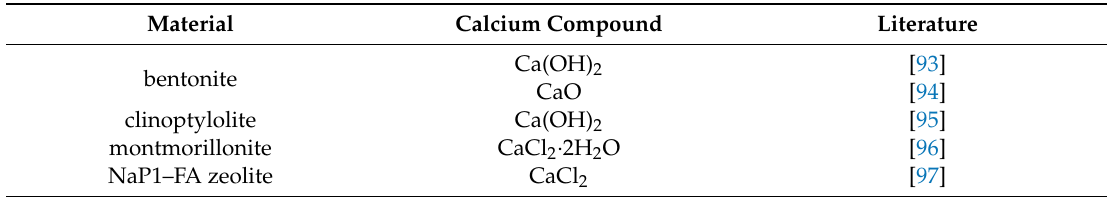
Table 3. Calcium compounds modification of reactive